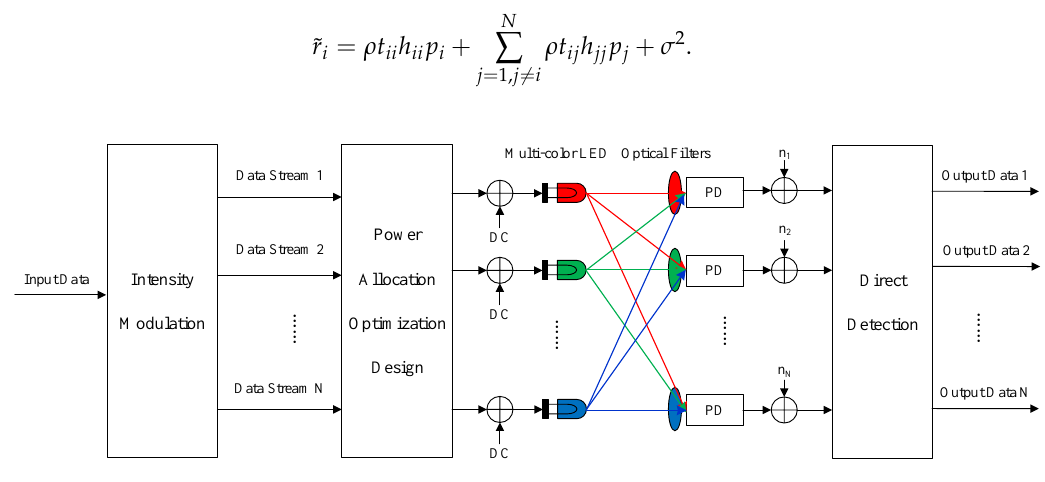
Figure 3. The model of the multi-color-based VLC